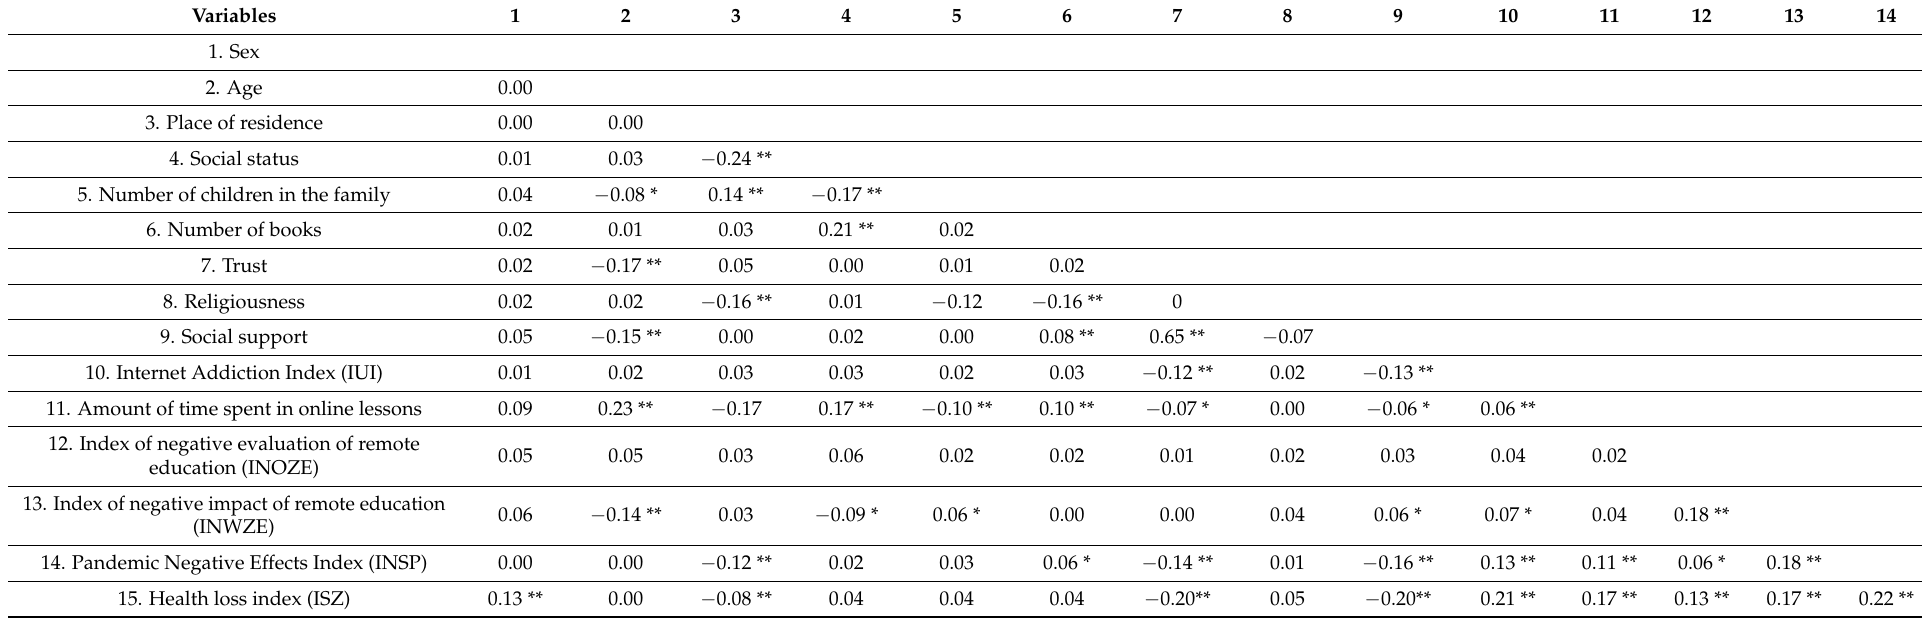
Table 5. Correlation coefficients among all predictors